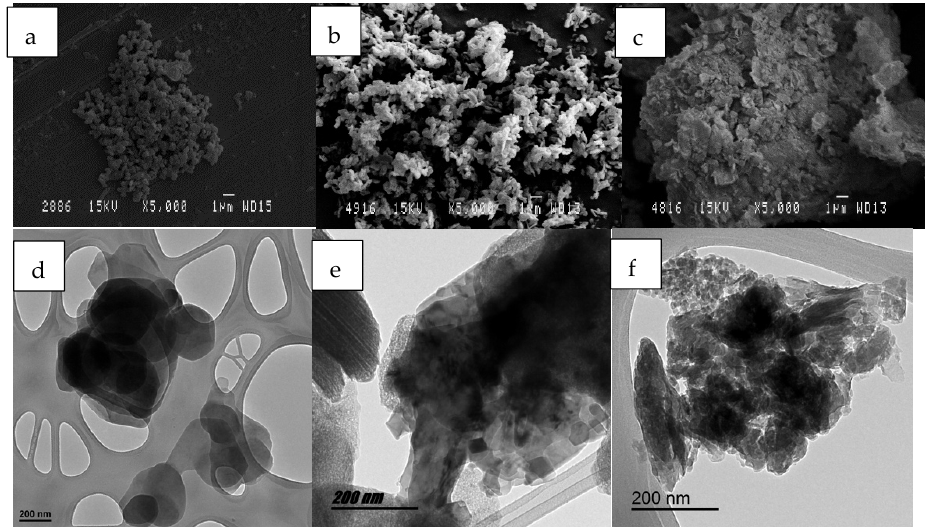
Figure 18. SEM micrographies of different HC samples: ( a ) HC original; ( b ) HC calcinated; ( c ) HC reconstructed. TEM micrographies of different HC samples: ( d ) HC original; ( e ) HC calcinated; ( f ) HC reconstructed.